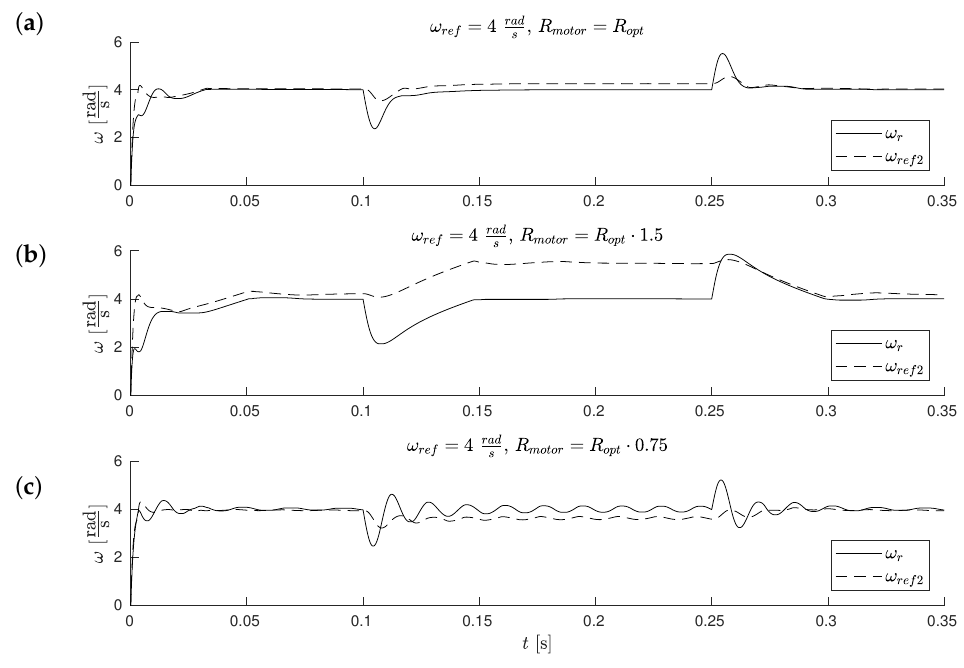
Figure 11. Measured ω r and corrected reference ω ref 2 speeds waveforms for different estimation errors of motor resistance (the initial position equals 30 ◦ ) ( a ) R motor = R opt , ( b ) R motor = 1.5 R motor = 0.75 R opt ·